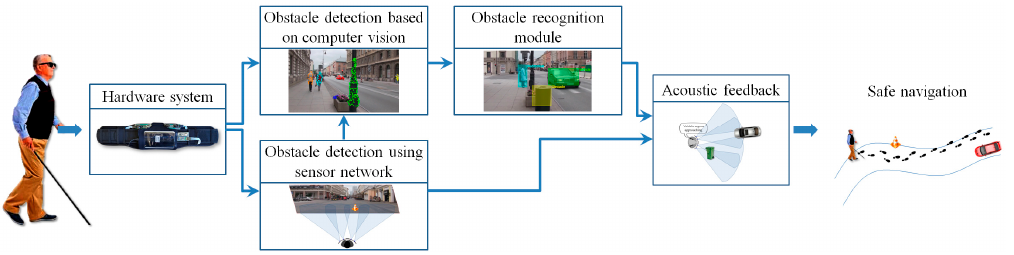
Figure 2. The software architecture of the proposed framework.